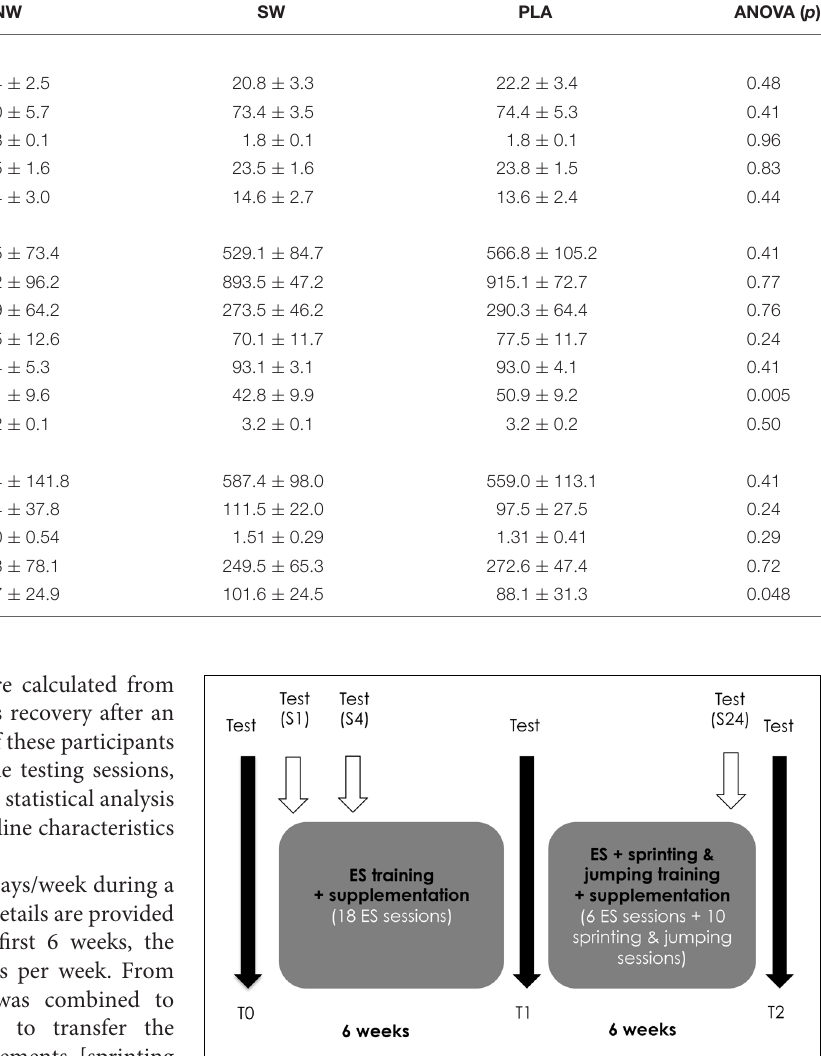
FIGURE 1 | Overview of the experimental protocol. Three testing sessions were organized before (T0), and after 6 (T1) and 12 weeks (T2) of training to evaluate the training adaptations. The recovery kinetics of neuromuscular properties were evaluated after the 1st (S1), 4th (S4), and last (S24) electrostimulation (ES)